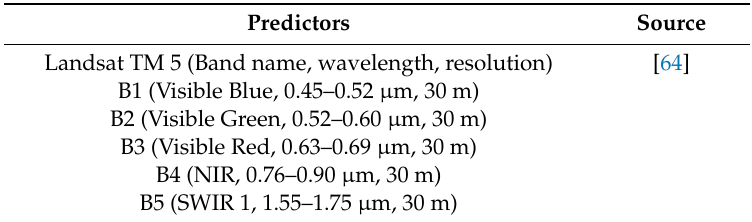
Table 2. List of bands (Landsat TM 5 and Landsat 8), Grey Level Co-occurrence Metrics (GLCM) texture and vegetation indices with code used in this